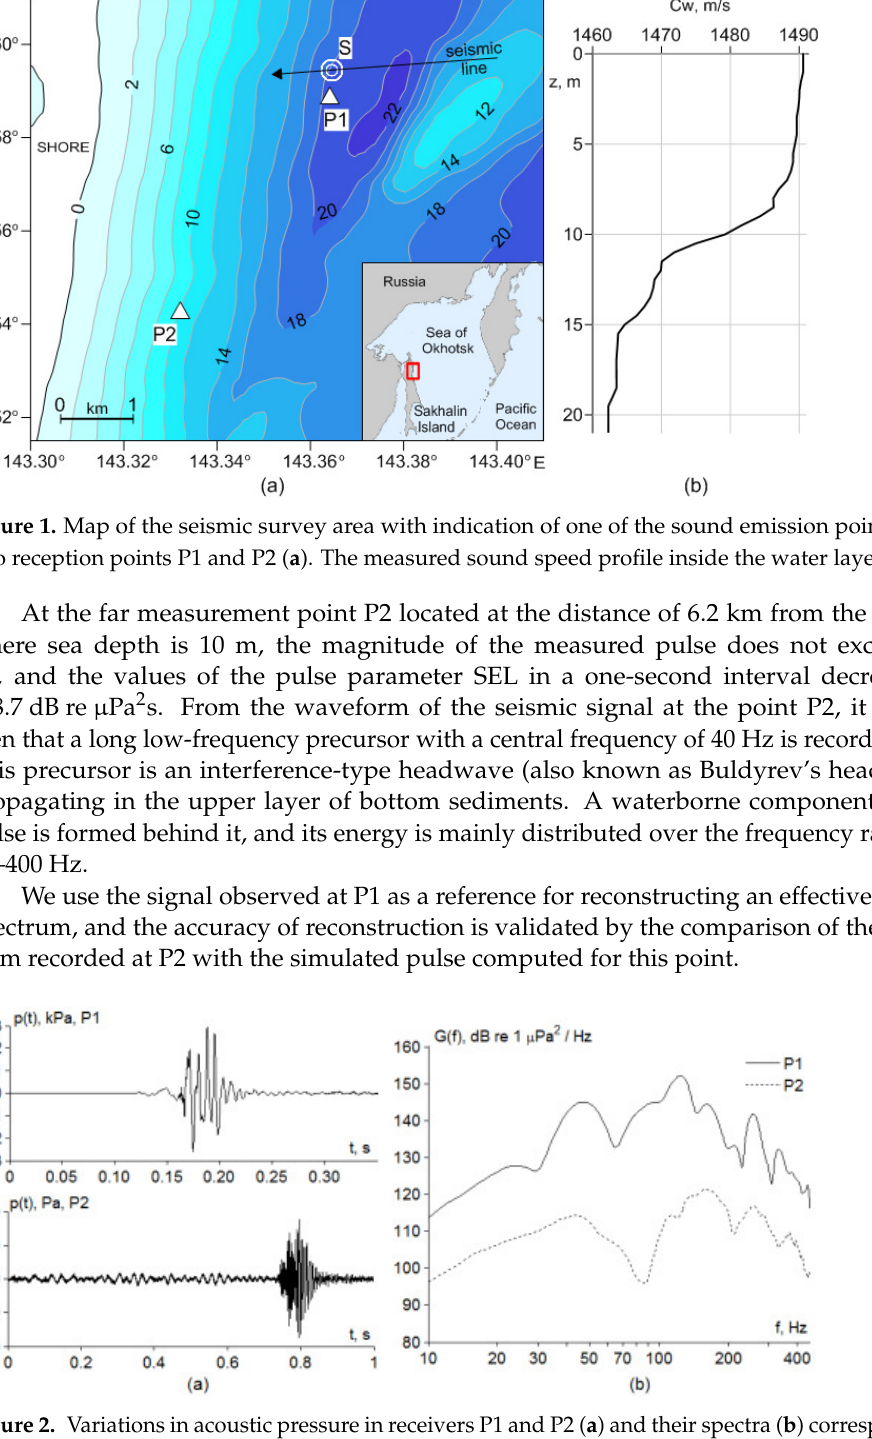
Figure 2. Variations in acoustic pressure in receivers P1 and P2 ( a ) and their spectra ( b ) corresponding to a seismic survey signal emitted at point